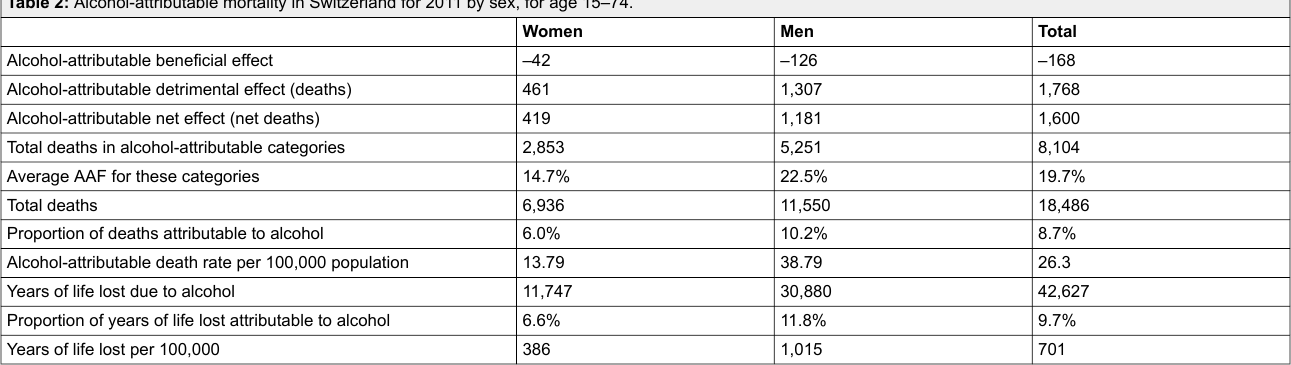
Table 2: Alcohol-attributable mortality in Switzerland for 2011 by sex, for age 15–74.